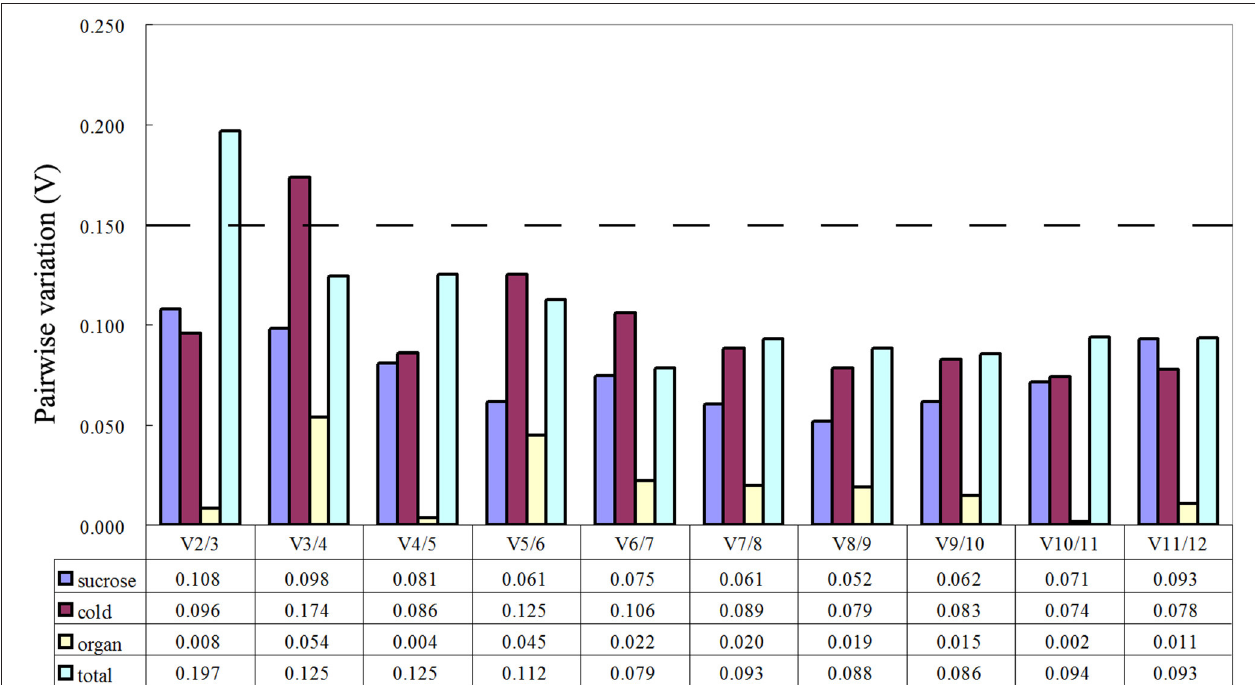
FIGURE 2 | Determination of the optimal number of reference genes for normalization by pairwise variation (V) using geNorm. The pairwise variation (Vn/Vn + 1) was calculated between normalization factors NFn and NFn + 1, by geNorm to determine the optimal number of reference genes for qRT-PCR data normalization.